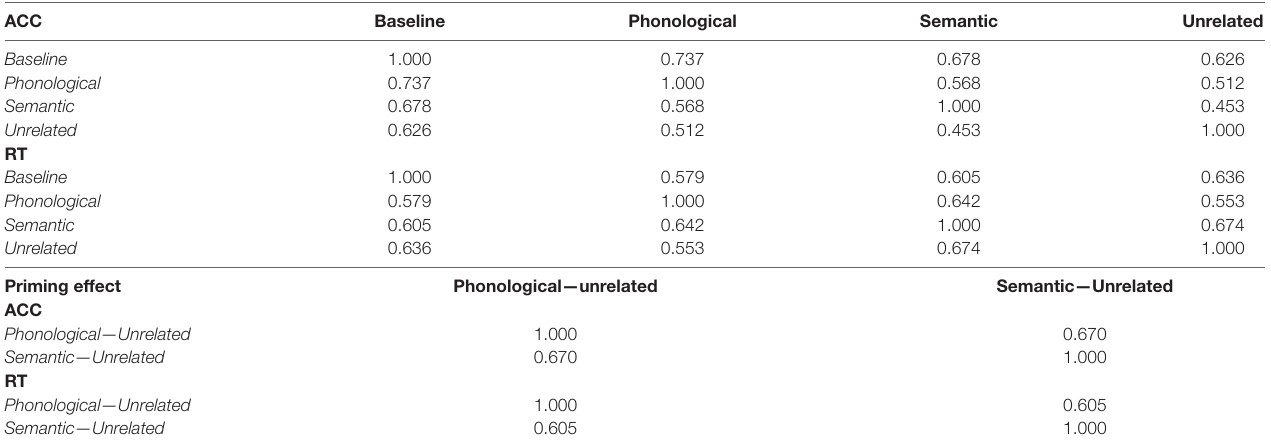
TABLE 3 | The correlation matrix between ACC/RT under each conditions of the